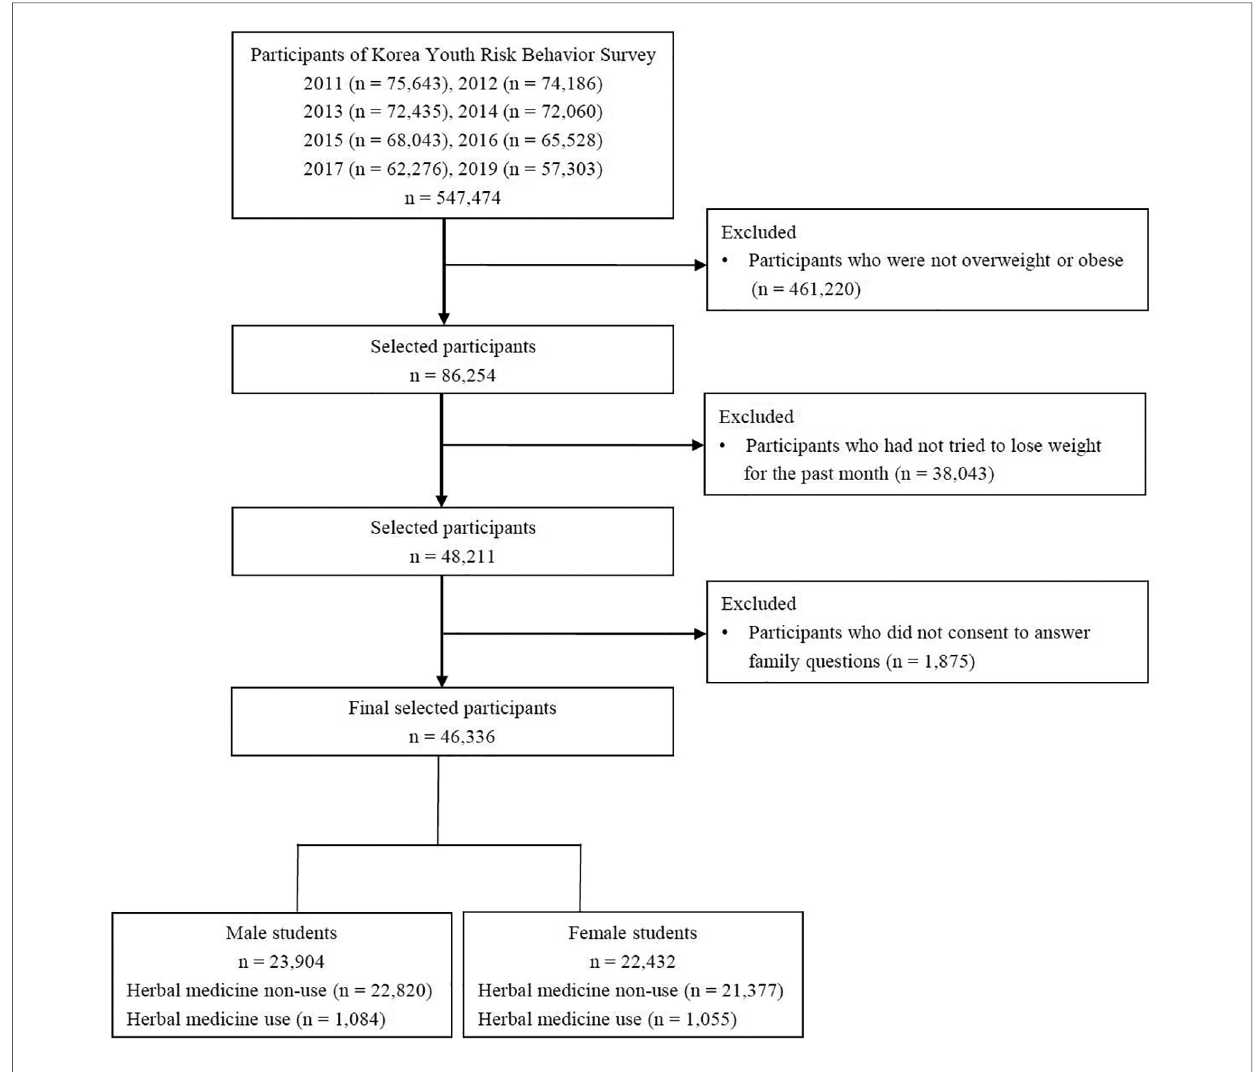
FIGURE 1 Flowchart for study participant